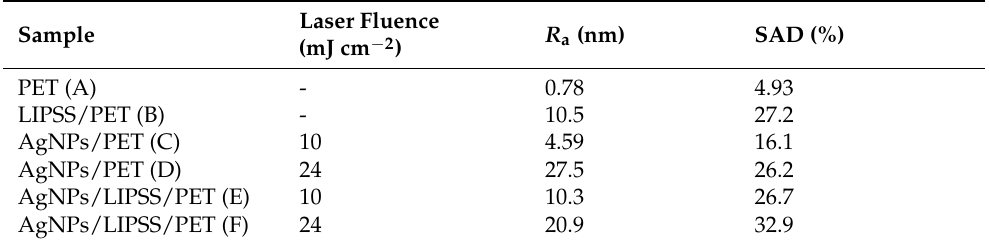
Table 1. Image characteristics (average surface roughness R a and surface area difference SAD) derived from AFM analysis. The designation of the samples corresponds to the Figure